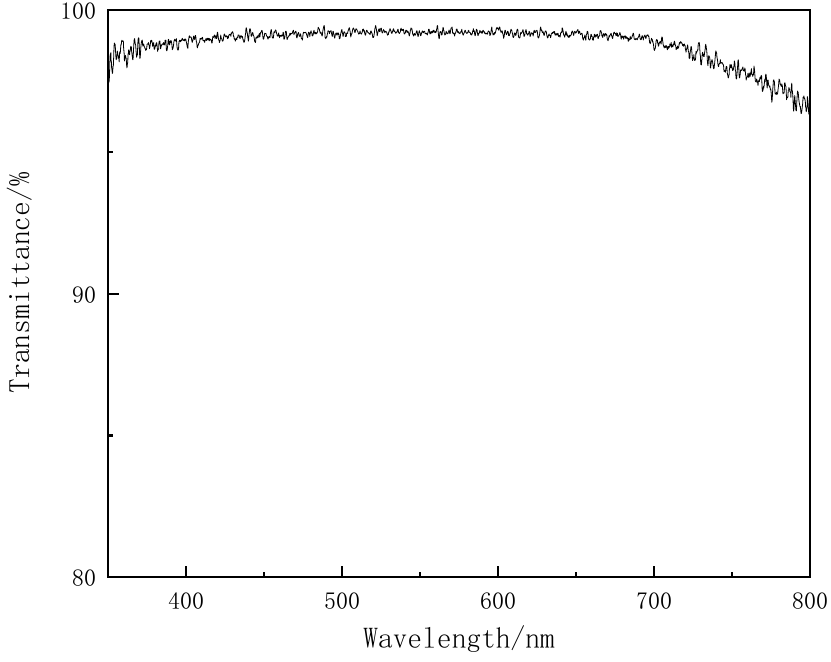
Figure 11. Light transmittance curves of the compound bis[(3-ethyl-3-methoxyoxetane)propyl]diphenylsilane. Table 7. Light transmittance of bis[(3-ethyl-3-methoxyoxetane)propyl]diphenylsilane.